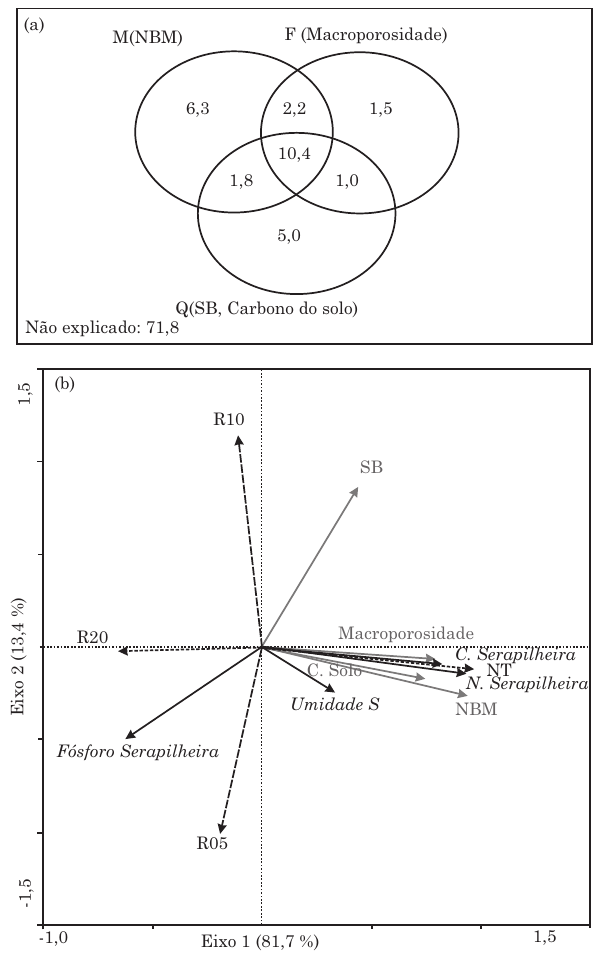
Figura 1. Influência dos atributos físicos, químicos e microbiológicos sobre o carbono (C, Serapilheira), nitrogênio (N, Serapilheira), fósforo da serapilheira e umidade (Umidade S) da serapilheira. (a) Decomposição da variância por meio da análise da pRDA das variáveis microbiológica (NBM), física (macroporosidade) e químicas (SB e carbono do solo), (b) RDA das variáveis selecionadas pela pRDA (p<0,05, teste de Monte Carlo). As setas de pontos referentes às áreas representam o centroide; as negras, as variáveis da serapilheira; e as cinzas, as variáveis